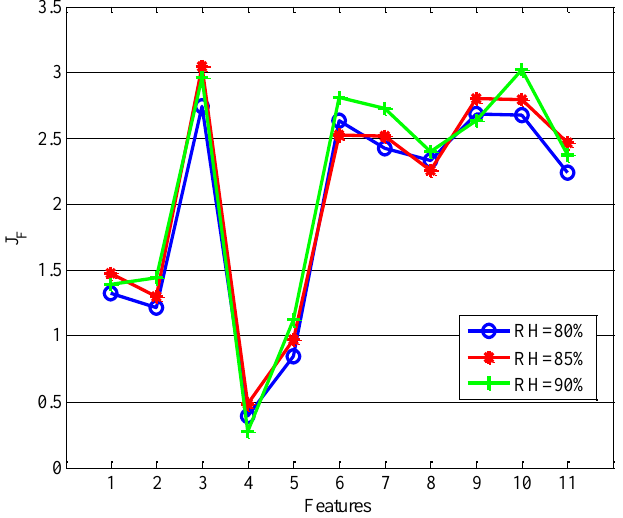
Figure 12. Fisher criterions of IR features. 1—Mean; 2—Median; 3—Maximum; 4—Minimum; 5—Mode; 6—Rang; 7—Variance; 8—Skewness; 9—Kurtosis; 10—Entropy;